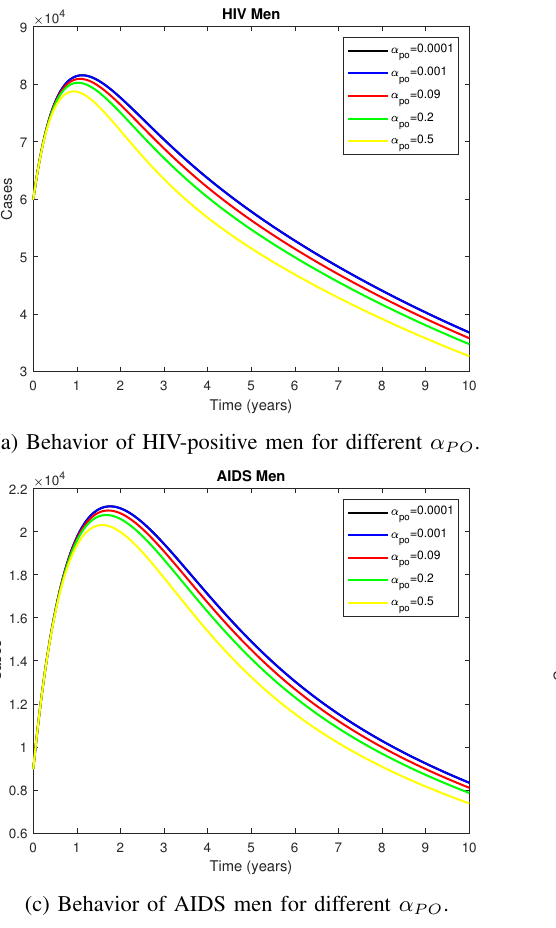
Fig. 11: Study of the compartments of HIV and AIDS for different values of α PO